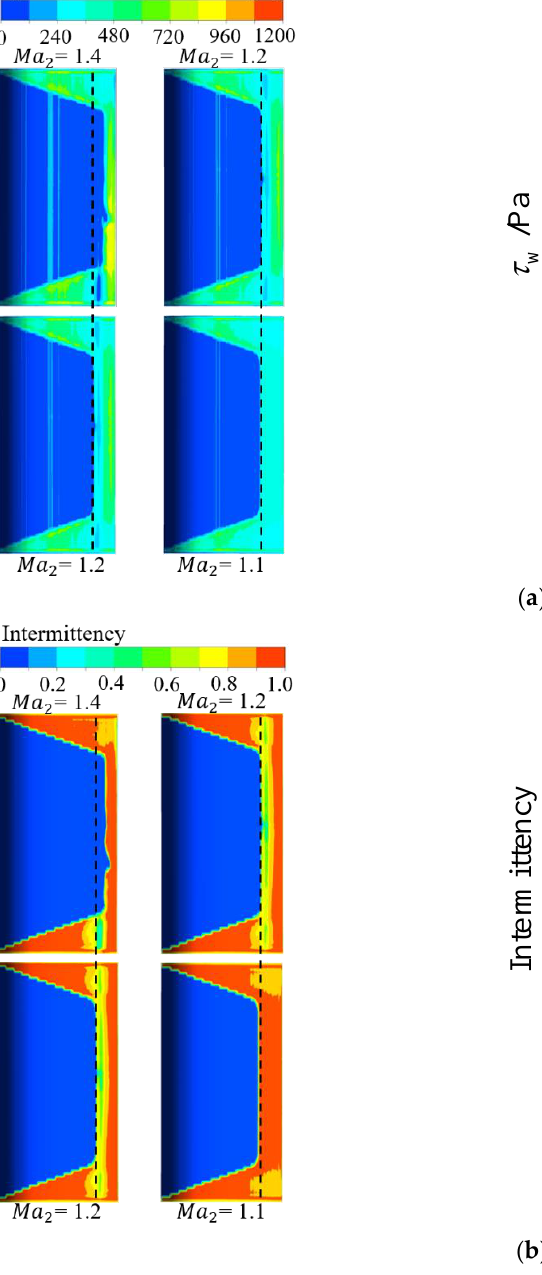
Figure 11. Intermittency and wall shear distribution of blade suction surface ( Ma > 1). ( a ) Wall shear; ( b ) intermittency.